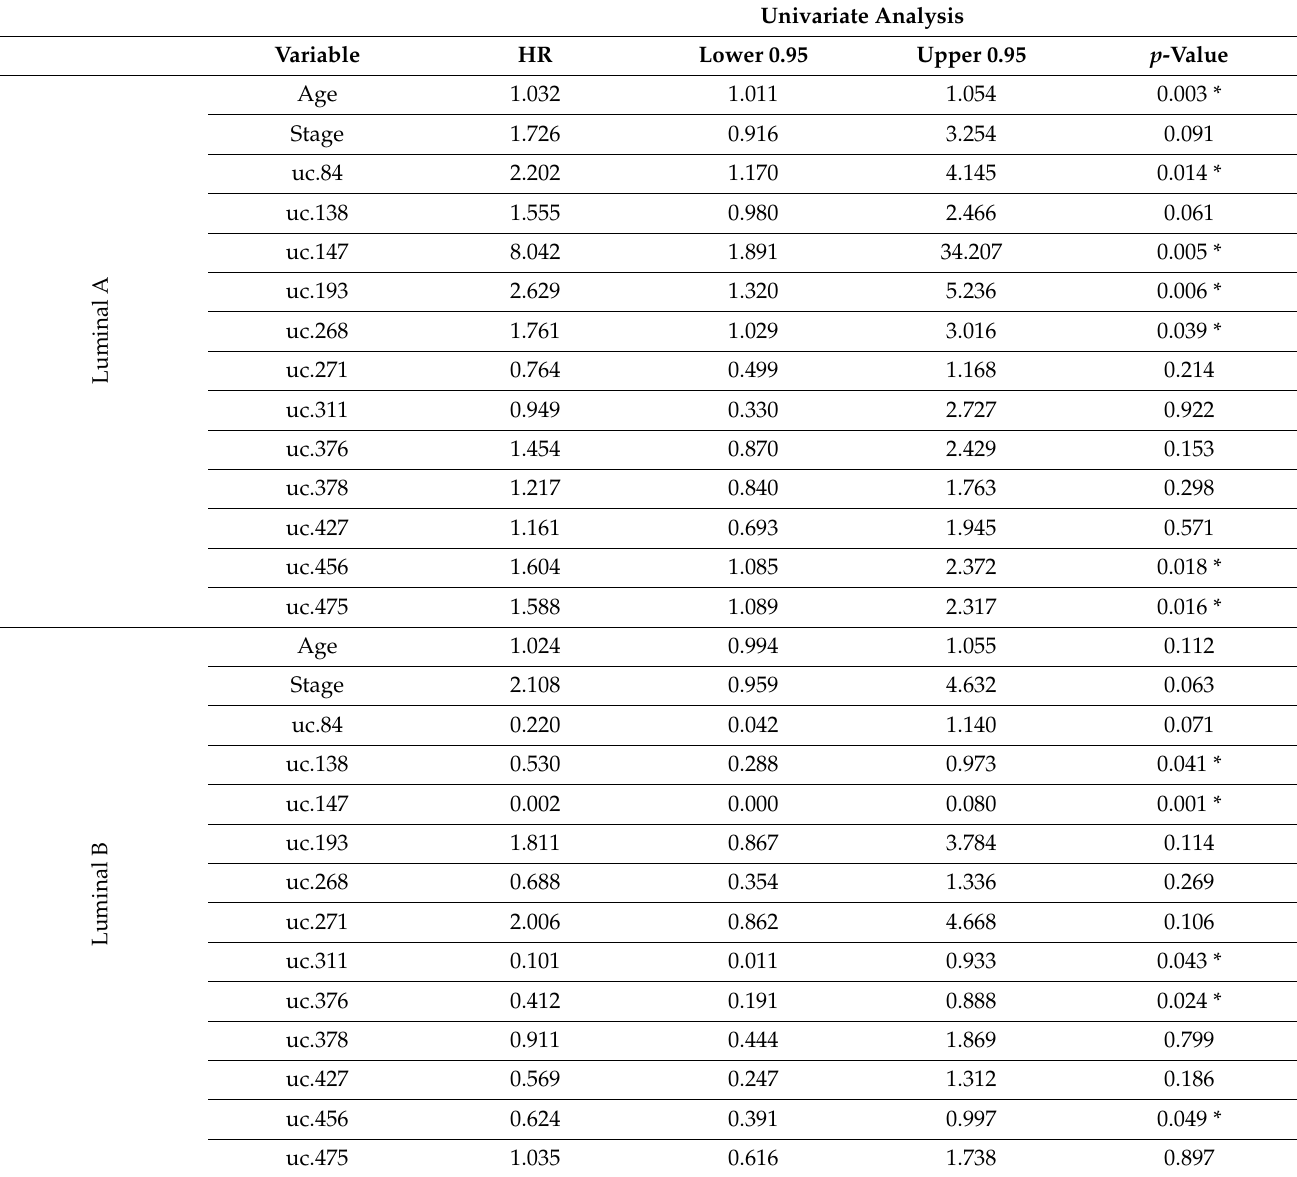
Table 3. Summary of univariate Cox regression analysis of T-UCRs in overall survival among subtypes. Univariate